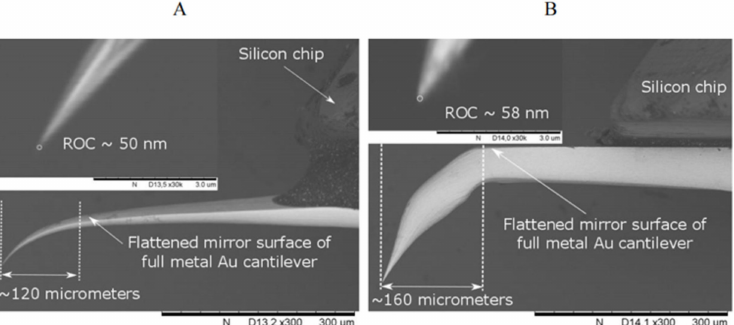
Figure 8. SEM images of two all-metal Au probes, attached to silicon AFM chips, with proper ( A ) and improper ( B ) distance between the tip and the flattened mirror surface of thinner ( A ) and thicker ( B ) all-metal Au cantilevers. The tips of these all-metal Au probes were obtained by electrochemical etching in 5 M NH 4 Cl aqueous solution at an alternating voltage from 1.0 to 4.5 V with a sinusoidal waveform frequency of 500 Hz. Magnification: 300 (insertions 30,000 ). × ×